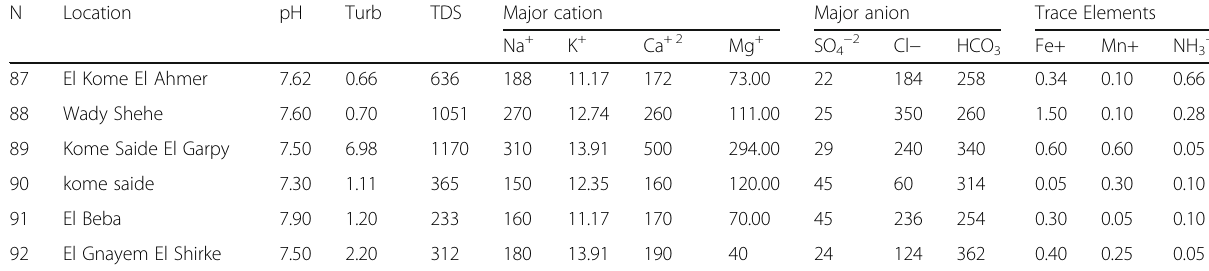
Table 4 Results of chemical analyses of studied groundwater samples in Assuit Governorate (Continued)